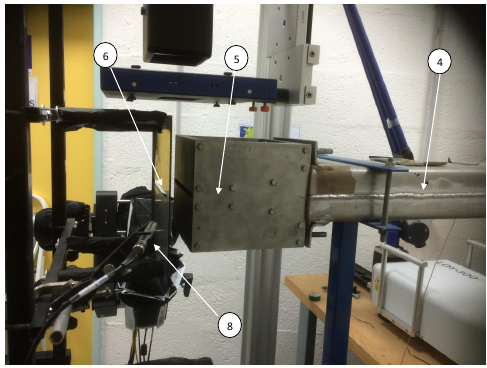
Figure 3. Experimental Set Up.